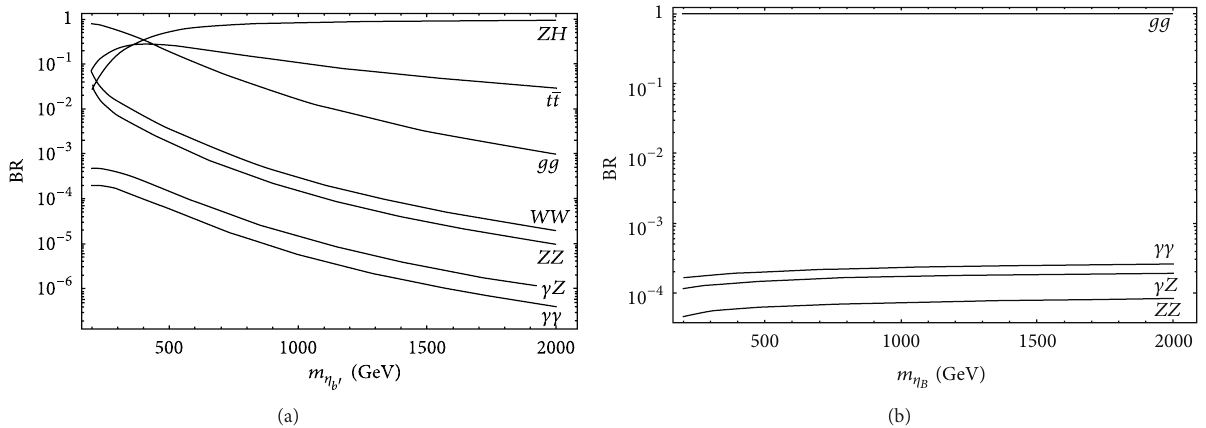
Figure 4: Branching ratios as given in [36] for 𝜂 𝑄 quarkonium, considering a chiral 𝑏 󸀠 quark (a) and a down-type singlet vector-like 𝐵 quark (b), with 𝑚 𝐻 = 125 GeV/ 𝑐 2 . |𝑉 𝑡𝑏 󸀠 | ≃ 1 is assumed in the fourth generation case.